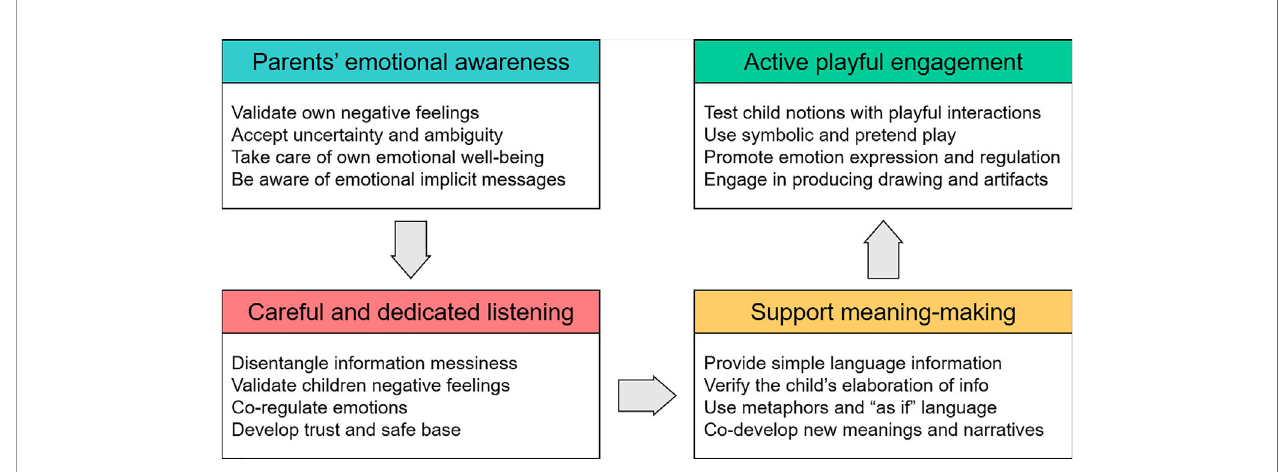
FIGURE 1 | Schematic overview of parental actions aimed at supporting children ’ s meaning-making during the Covid-19